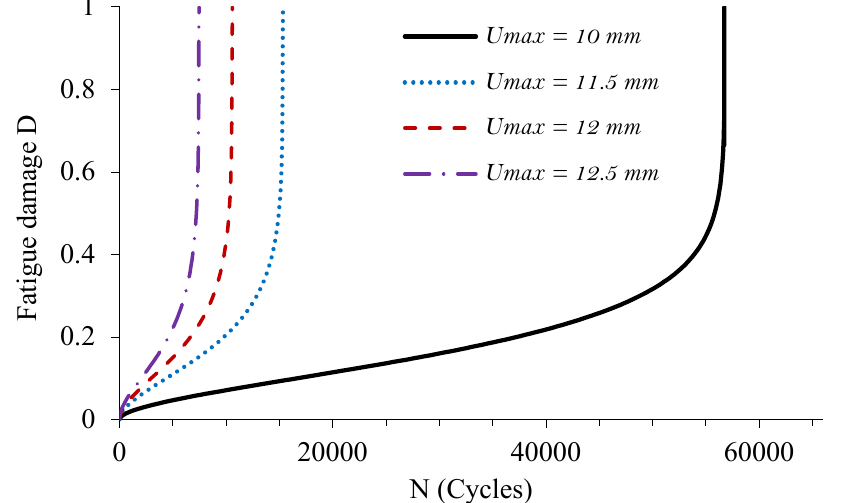
Figure 15. Simulated damage evolution at the extreme fixed outer layer of PA66GF20 specimens.